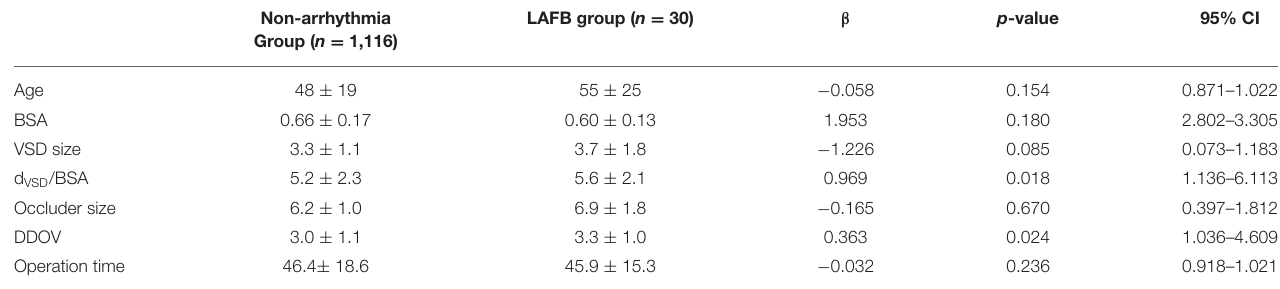
TABLE 4 | Logistic regression analysis of risk factors for LAFB after transcatheter closure of VSD in children. Non-arrhythmia Group ( n = 1,116)